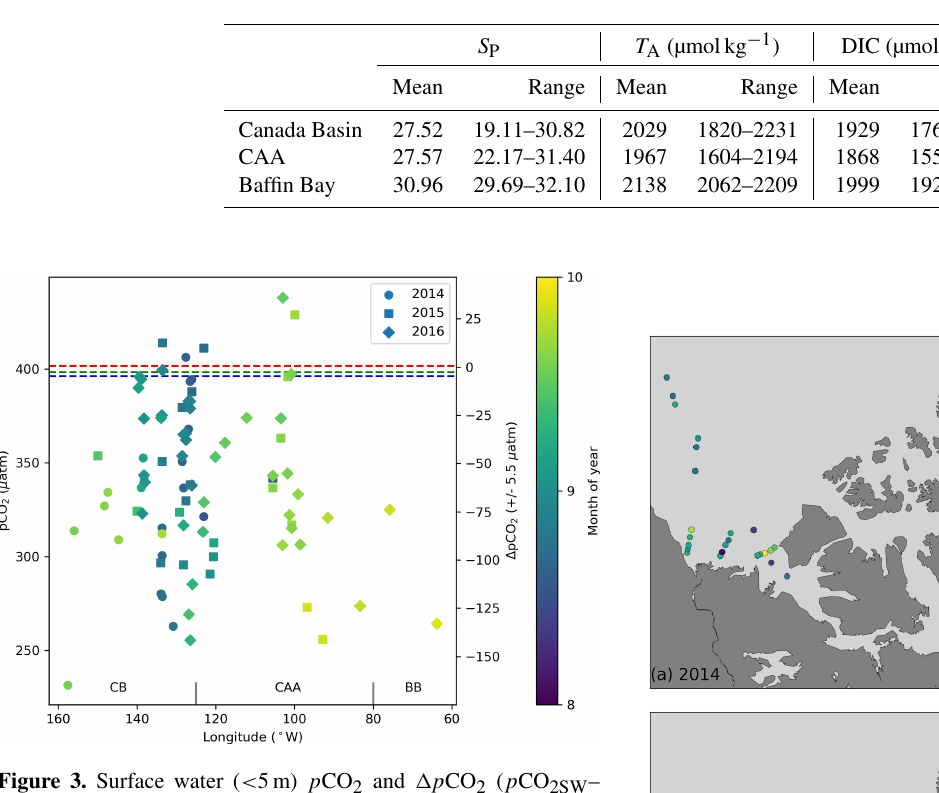
Table 3. Mean surface water ( < 10m) practical salinity ( S P ), total alkalinity ( T A ), dissolved organic carbon (DIC) and associated ranges in the three subregions of the study area in 2014, 2015 and 2016.